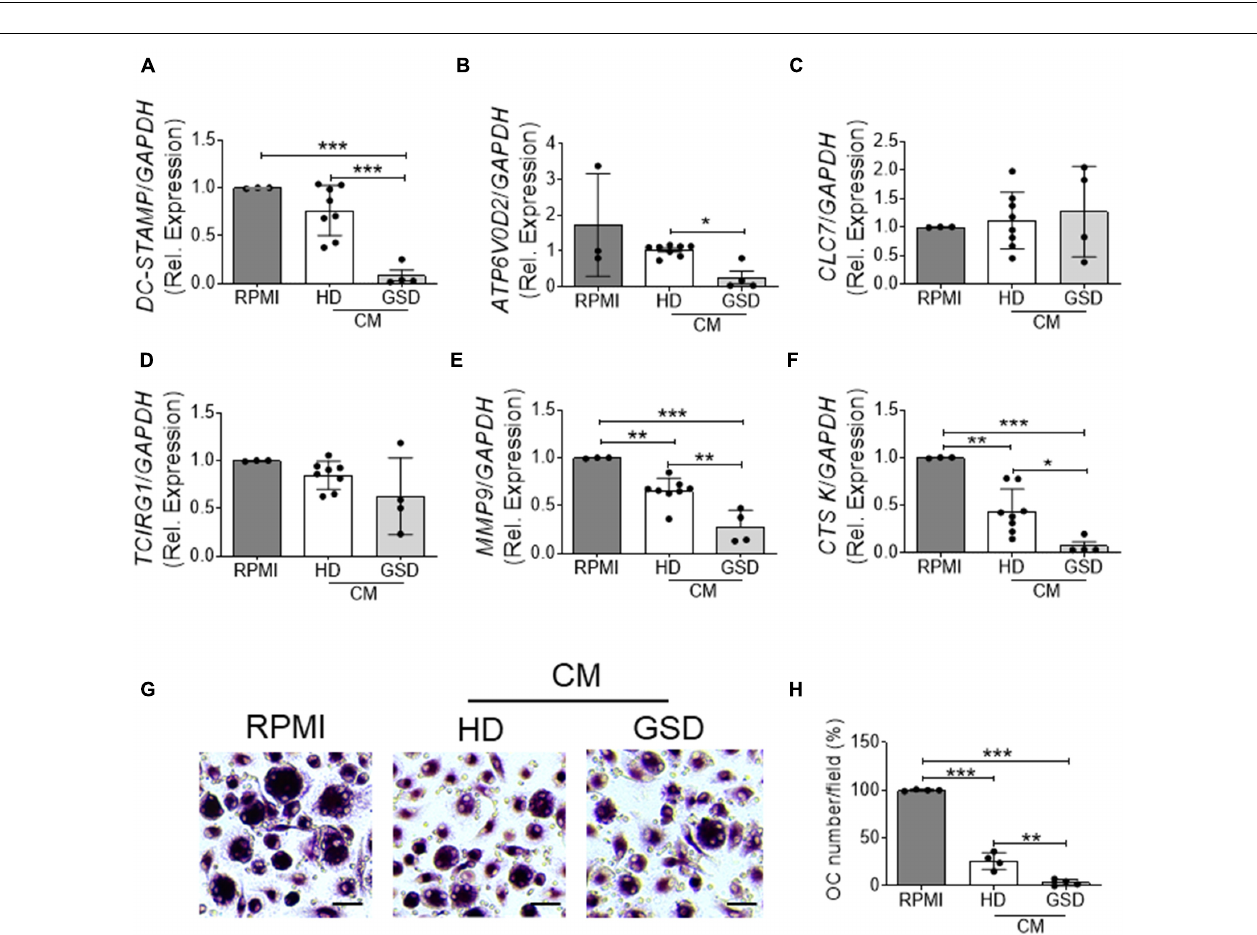
FIGURE 5 | (A–F) RNA was extracted from three HD-osteoclast precursors treated for 48 h with RPMI-1640 + M-CSF/RANKL as control (RPMI group) or 100% conditioned medium (CM) of aCD3/CD28 stimulated PBMC isolated from four patients and eight HD + hM-CSF/hRANKL and reverse transcribed; then cDNA was subjected to comparative Real-Time PCR using primer pairs and specific conditions for (A) DC-STAMP , (B) ATP6V0D2 , (C) CLC7 , (D) TCIRG1 , (E) MMP9 , and (F) CTSK genes. qRT-PCR Cycle threshold ranges are DC-STAMP : 19.5–28.2; ATP6V0D2 : 22.6–29.9; CLC7 : 23.0–27.0; TCIRG1 : 21.8–26.6; MMP9 : 18.0–22.6; CTSK : 20.9–28.6; GAPDH : 18.0–19.6. (G,H) PBMC were isolated from four HD and treated with RPMI-1640 + hM-CSF/hRANKL as control (RPMI group) or 100% conditioned medium (CM) of aCD3/CD28 stimulated PBMC isolated from four patients and four HD + hM-CSF/hRANKL. (G) Representative pictures of TRAcP staining. Scale bar: 30 µ m. (H) Percentage of TRAcP positive multinucleated ( > 3 nuclei) cells. Results are expressed as mean ± SD. * p < 0.05; ** p < 0.01; *** p < 0.001.